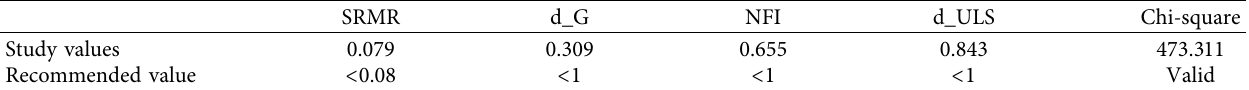
Table 6: Model fit indices.